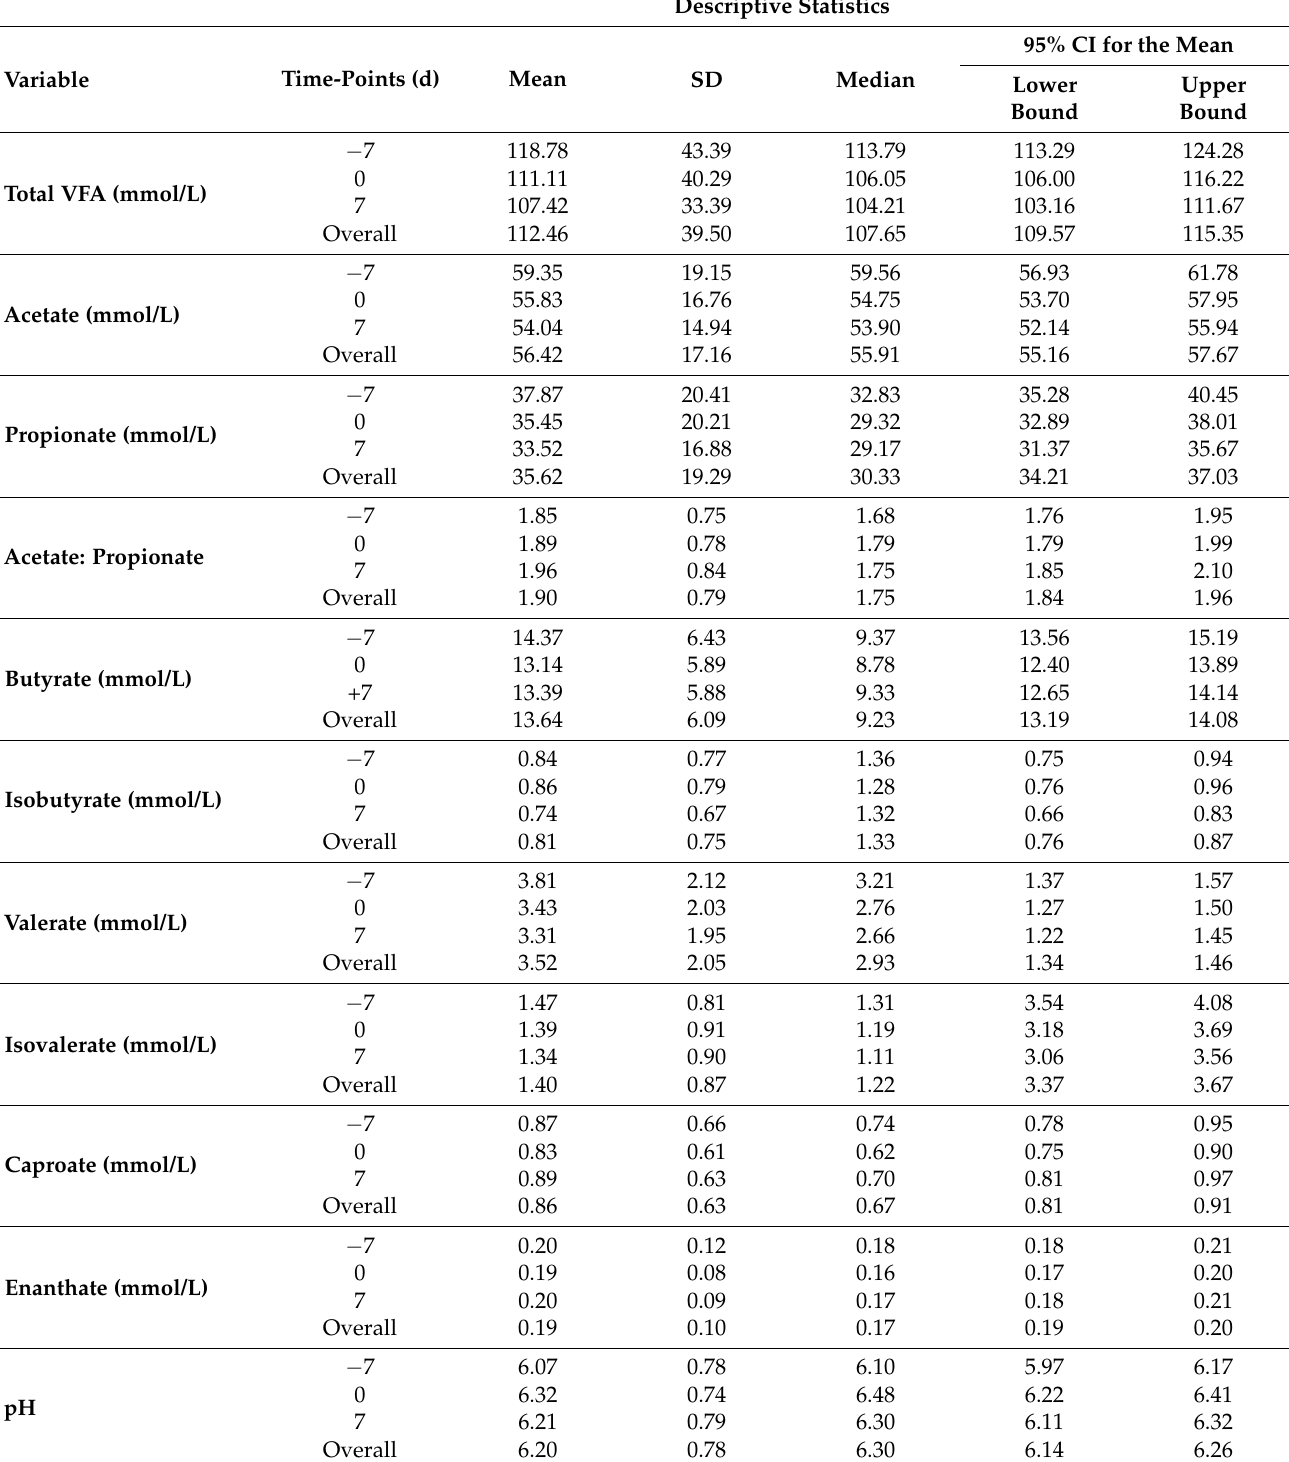
Table 2. Descriptive statistics for ruminal volatile fatty acid (VFA) concentration and pH values for the peri-weaning period in Holstein dairy calves. A total of 242, 241 and 239 samples were available at − 7 d (7 days pre-weaning), at 0 d (weaning), and 7 d (7 days post-weaning),